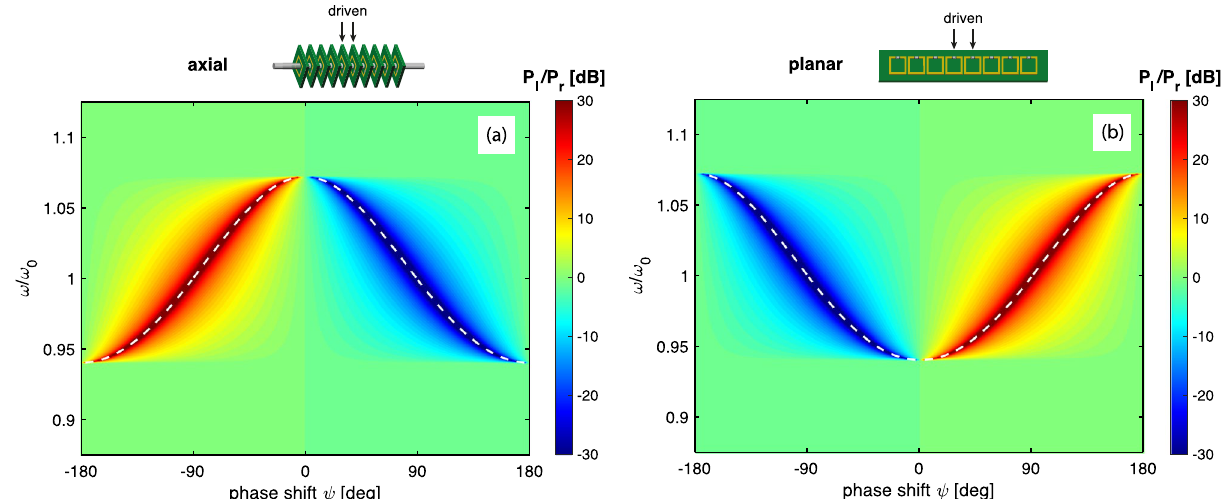
0.13 ( a ) and a planar array with κ =